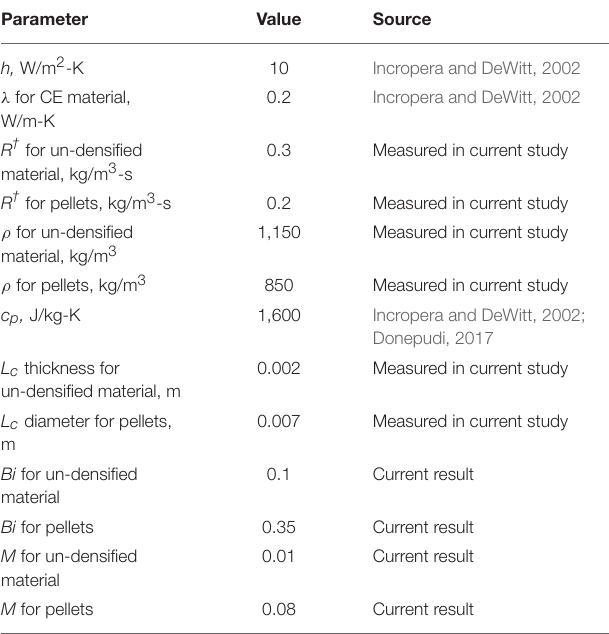
TABLE 3 | Estimated values for the parameters to determine the Bi and